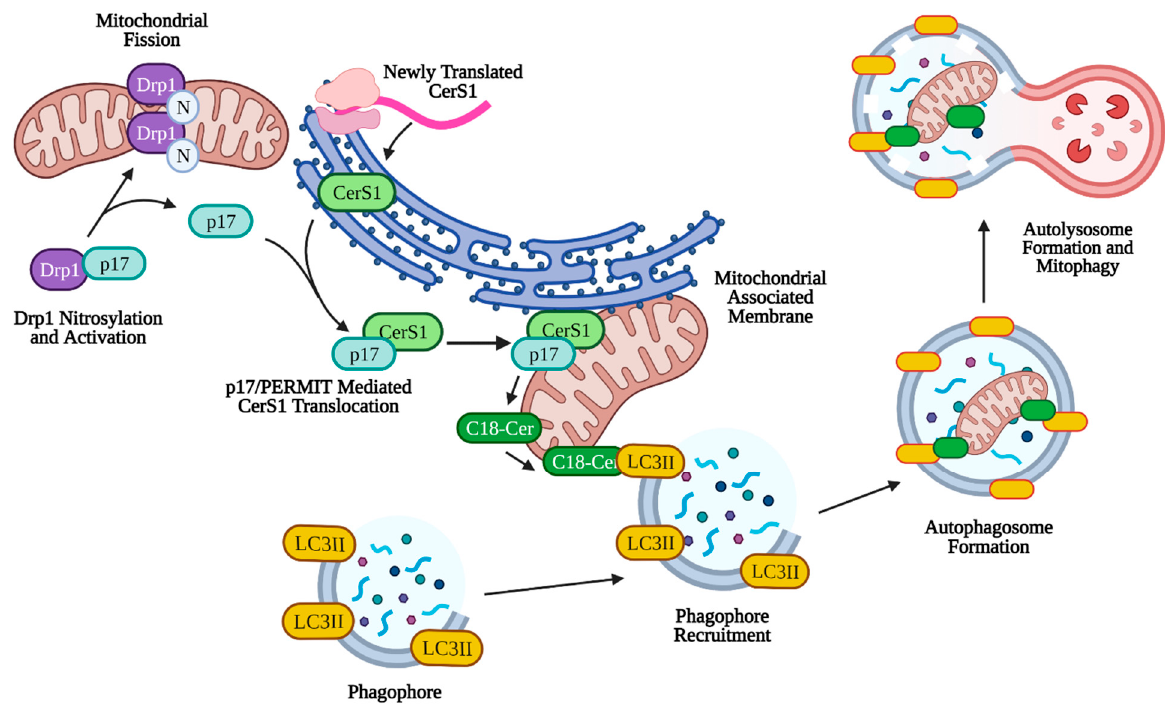
Figure 3. p17/PERMIT-mediated mitophagy. C18-ceramide induced mitophagy is facilitated by p17/PERMIT translocation of CerS1 to the mitochondria. Drp1 is activated by S-nitrosylation at C644, which releases p17/PERMIT and initiates mitochondrial fission. P17/PERMIT associates with newly translated CerS1 at the mitochondrial-associated membrane and is translocated via a mitochondrial signaling sequence (amino acids L21–R25). CerS1 is then able to produce C18-ceramide, which coats the outer mitochondrial membrane and directly binds autophagosomal LC3II, facilitating mitophagy. Created with BioRender.com (accessed on 11 May 2021).